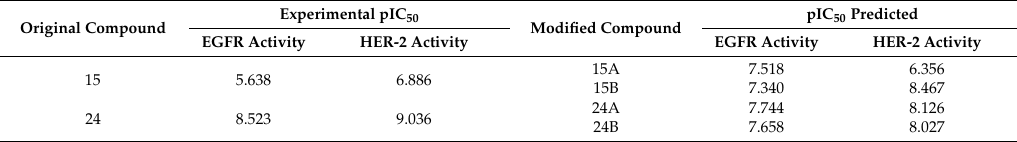
Figure 8. Original chemical structure of the compounds 15 and 24 and the new proposed compounds. (The red regions are groups that were substituted to compose the new molecules). Table 5. New compounds proposed from the 3D models and the predicted pIC 50 values.